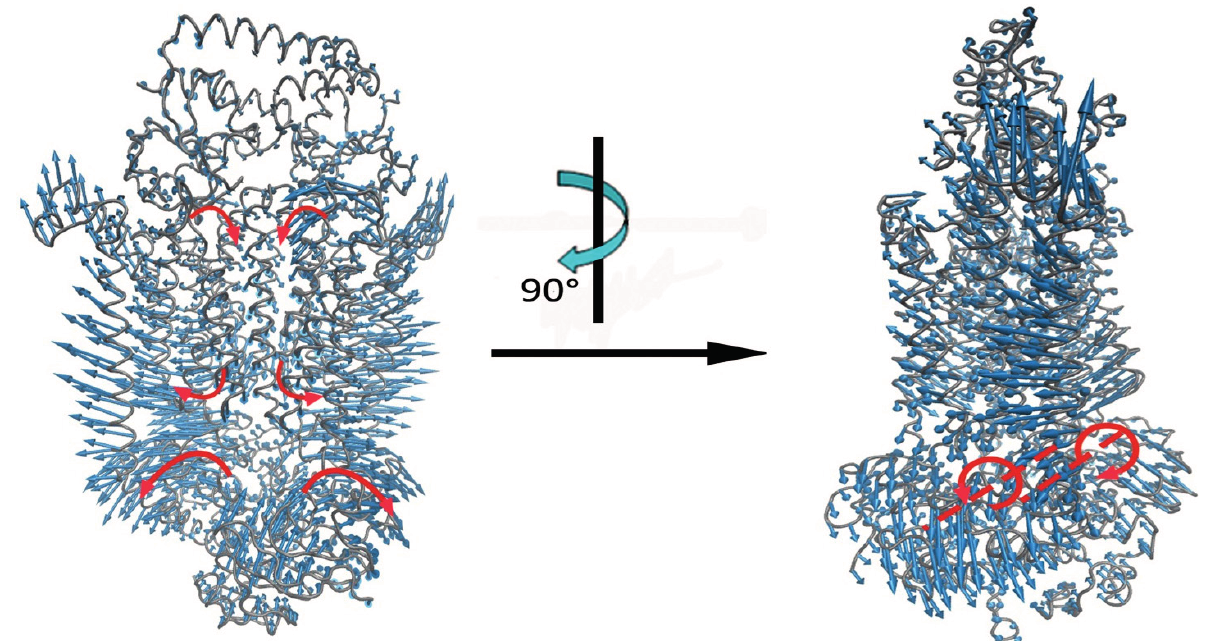
Figure 4. The functional motion that contributes to the channel-gating of